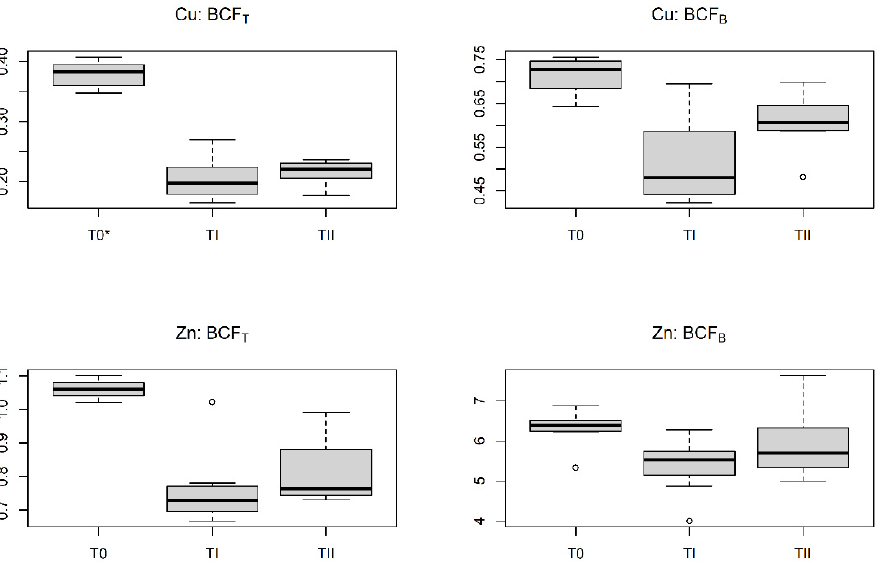
Figure 3. Bioconcentration factors for total (BCF T ) and bioavailable amounts (BCF B ) calculated for Cu and Zn in camelina; * for descriptions see Material and Methods. Statistically significant differences and p -value are presented in Table 2.